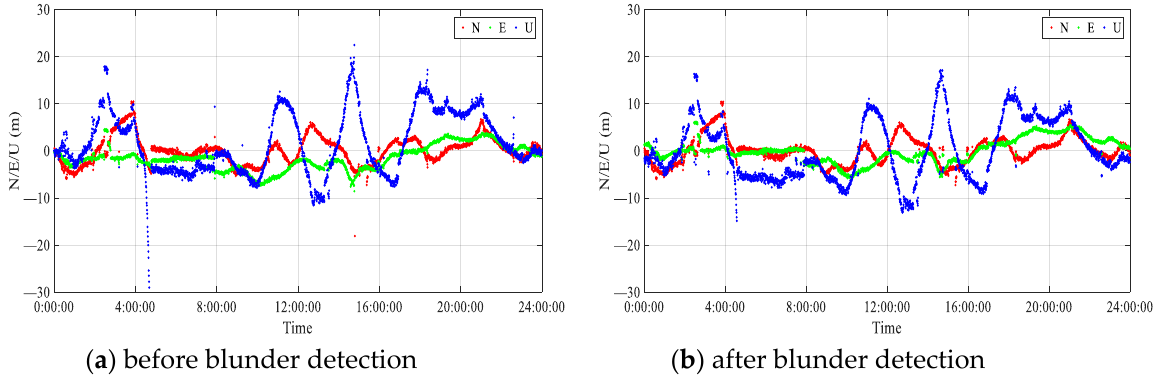
Figure 10. Time series of the N, E and U directions of SCO4 station based on GPS C2 and P2 obser- vation data before (a) and after (b) blunder detection.